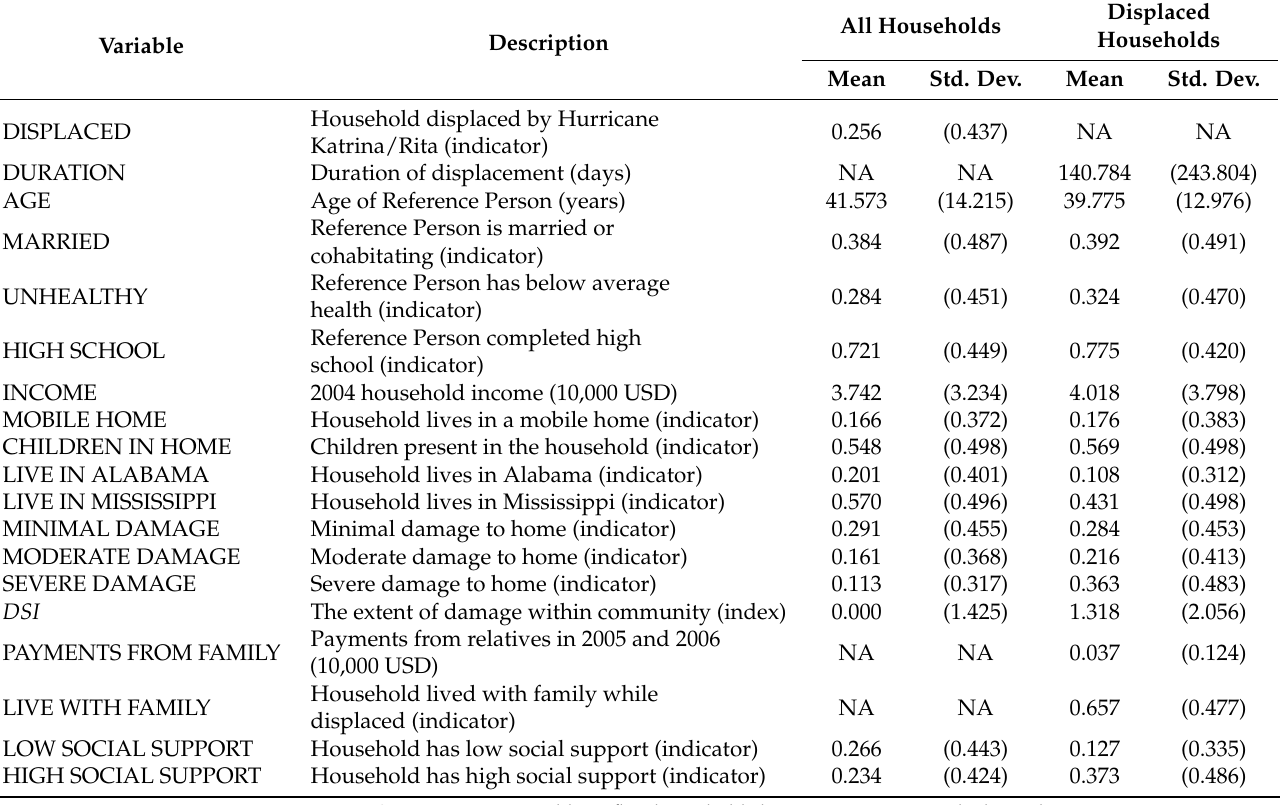
Table 2. Variable Definitions Descriptive